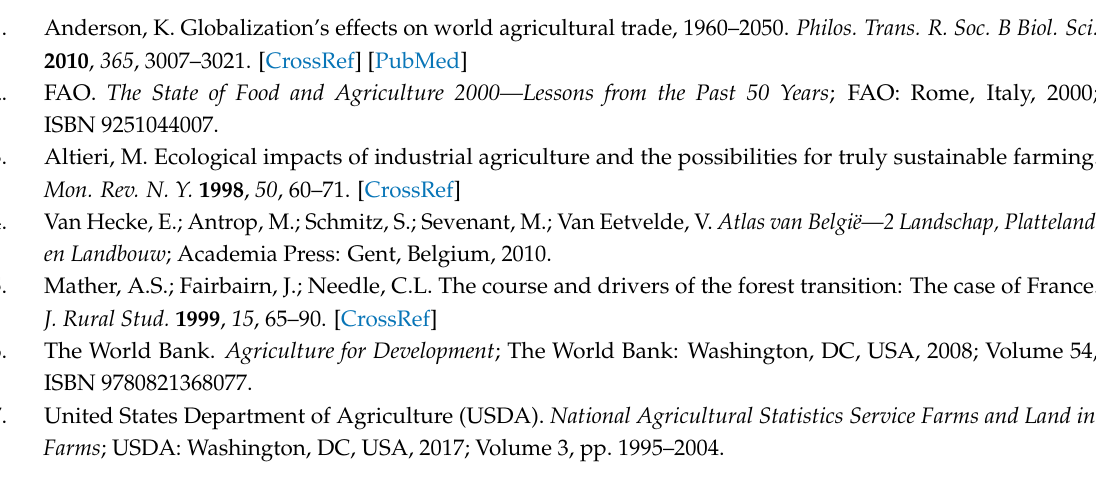
Table S1. Non-exhaustive overview of agricultural simulation models in literature; Table S2. AD AM ODD protocol. References [72–78] are cited in the supplementary